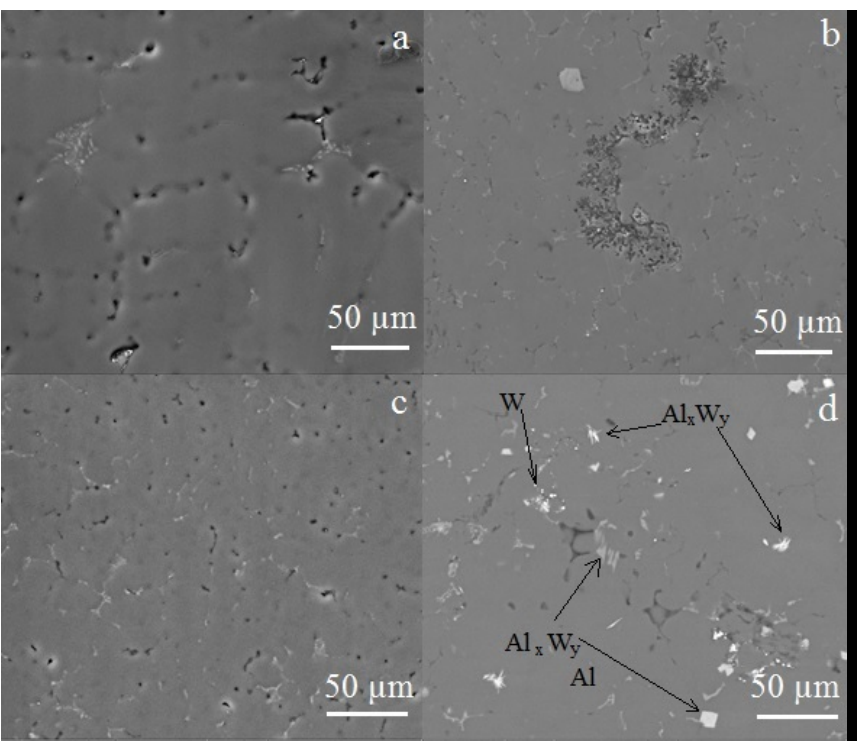
Figure 4. The SEM image of Al-Mg alloys: ( a ) Al-5Mg, ( b ) Al-5Mg-0.3W, ( c ) Al-5Mg-0.5W, and ( d ) Al-5Mg-0.8W.